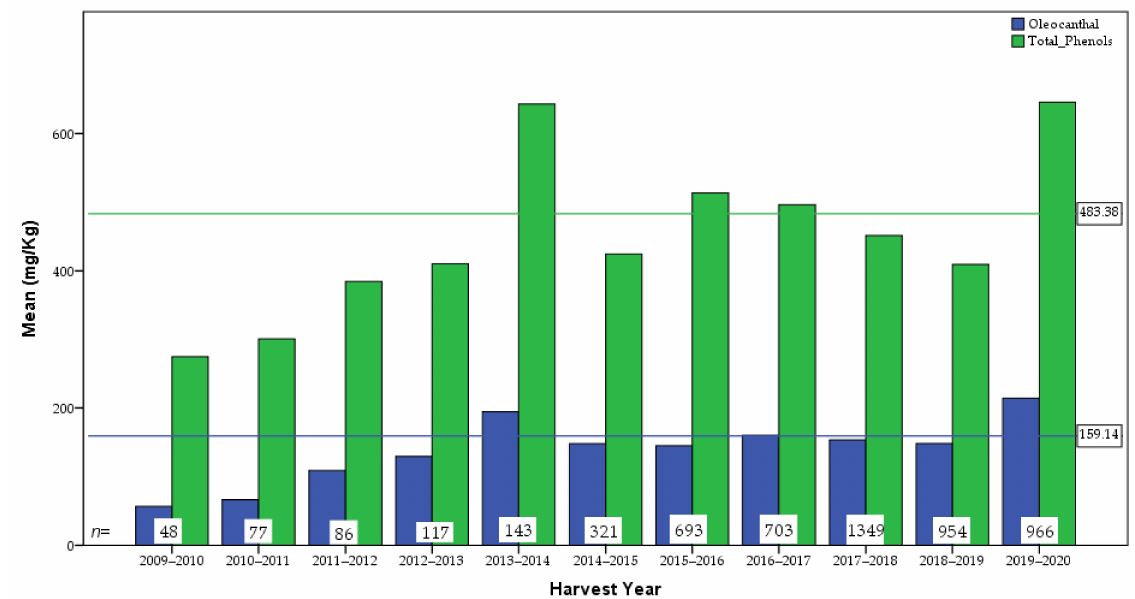
Figure 4. Difference in concentration of oleocanthal and total phenols in relation to harvest year (the horizontal green and blue lines represent the overall mean of oleocanthal and total phenols, respectively. The number in the base of the bars represents the sample size of each